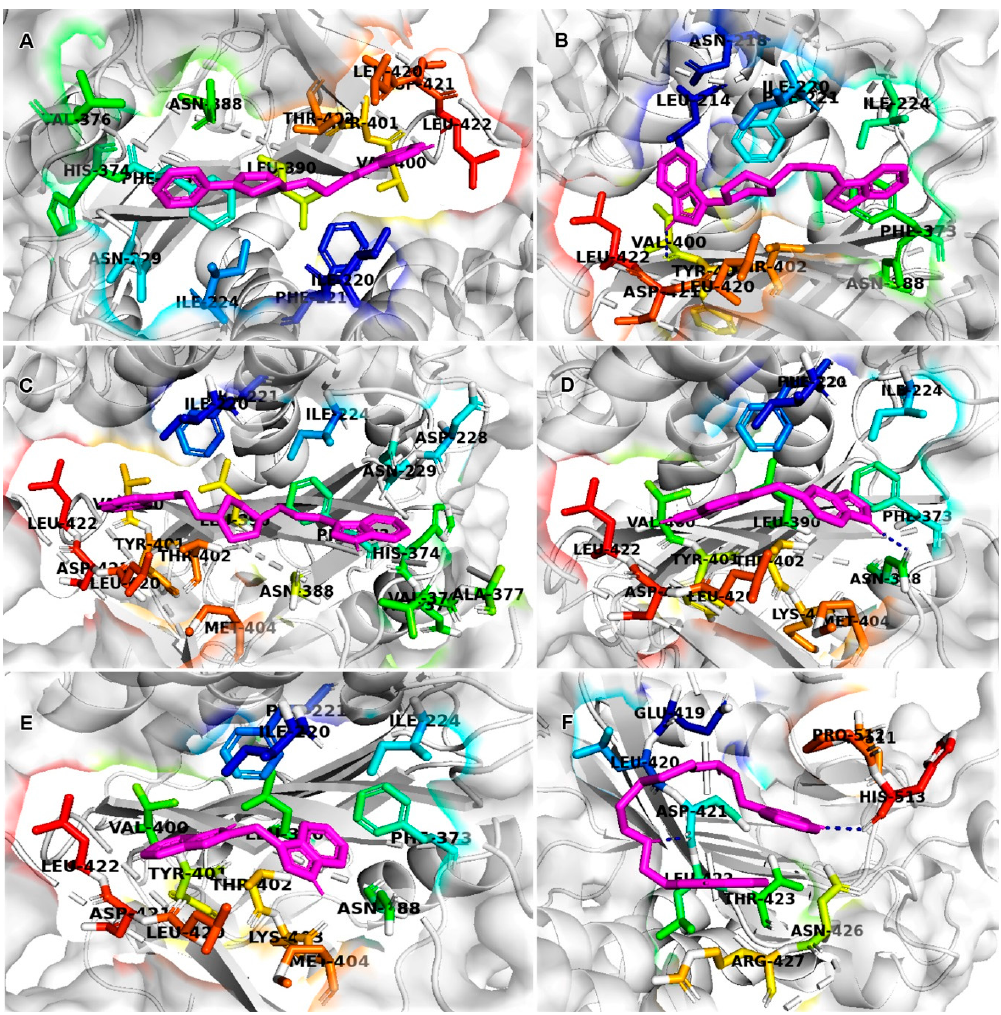
Figure 7. Protein–ligand interaction analysis of the best five compounds. ( A ) CID6917760 compound interacted with (ne–8.9 kcal / mole) active site of G6PD (dimer interface domain) functional residues; ( B ) CID9820229 compound interacted to (ne–7.6 kcal / mole) active site of G6PD (dimer interface domain) functional residues; ( C ) CID5221957 compound interacted with (ne–7.3 kcal / mole)